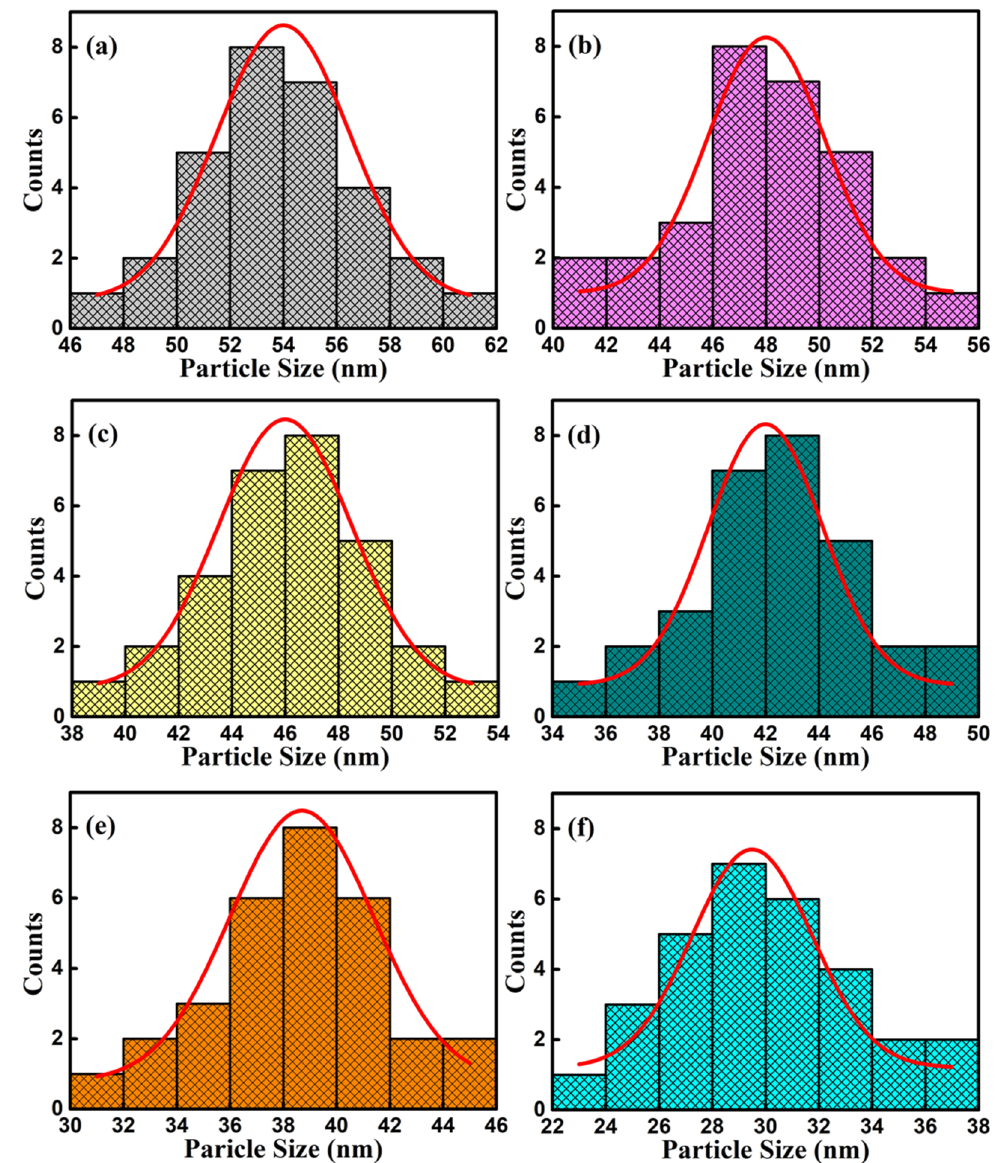
Figure 6. Histograms for particle size distribution and Gaussian fitting curve of ( a ) BFO, ( b ) BFC 0.01 O, ( c ) BFC 0.03 O, ( d ) BFC 0.05 O, ( e ) BFC 0.07 O and ( f ) BFC 0.10 O thin films.